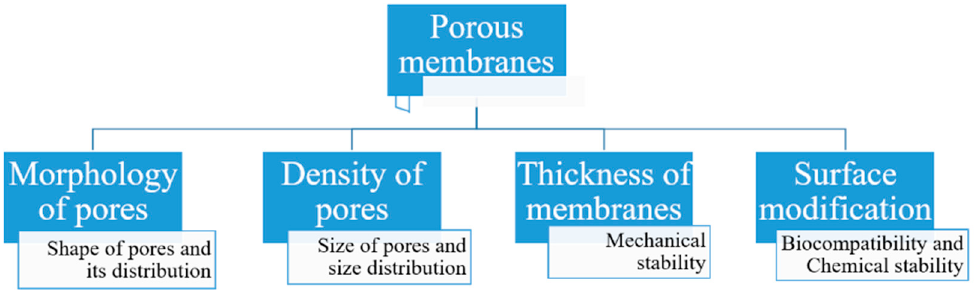
Figure 10. Key characteristics of porous membranes.